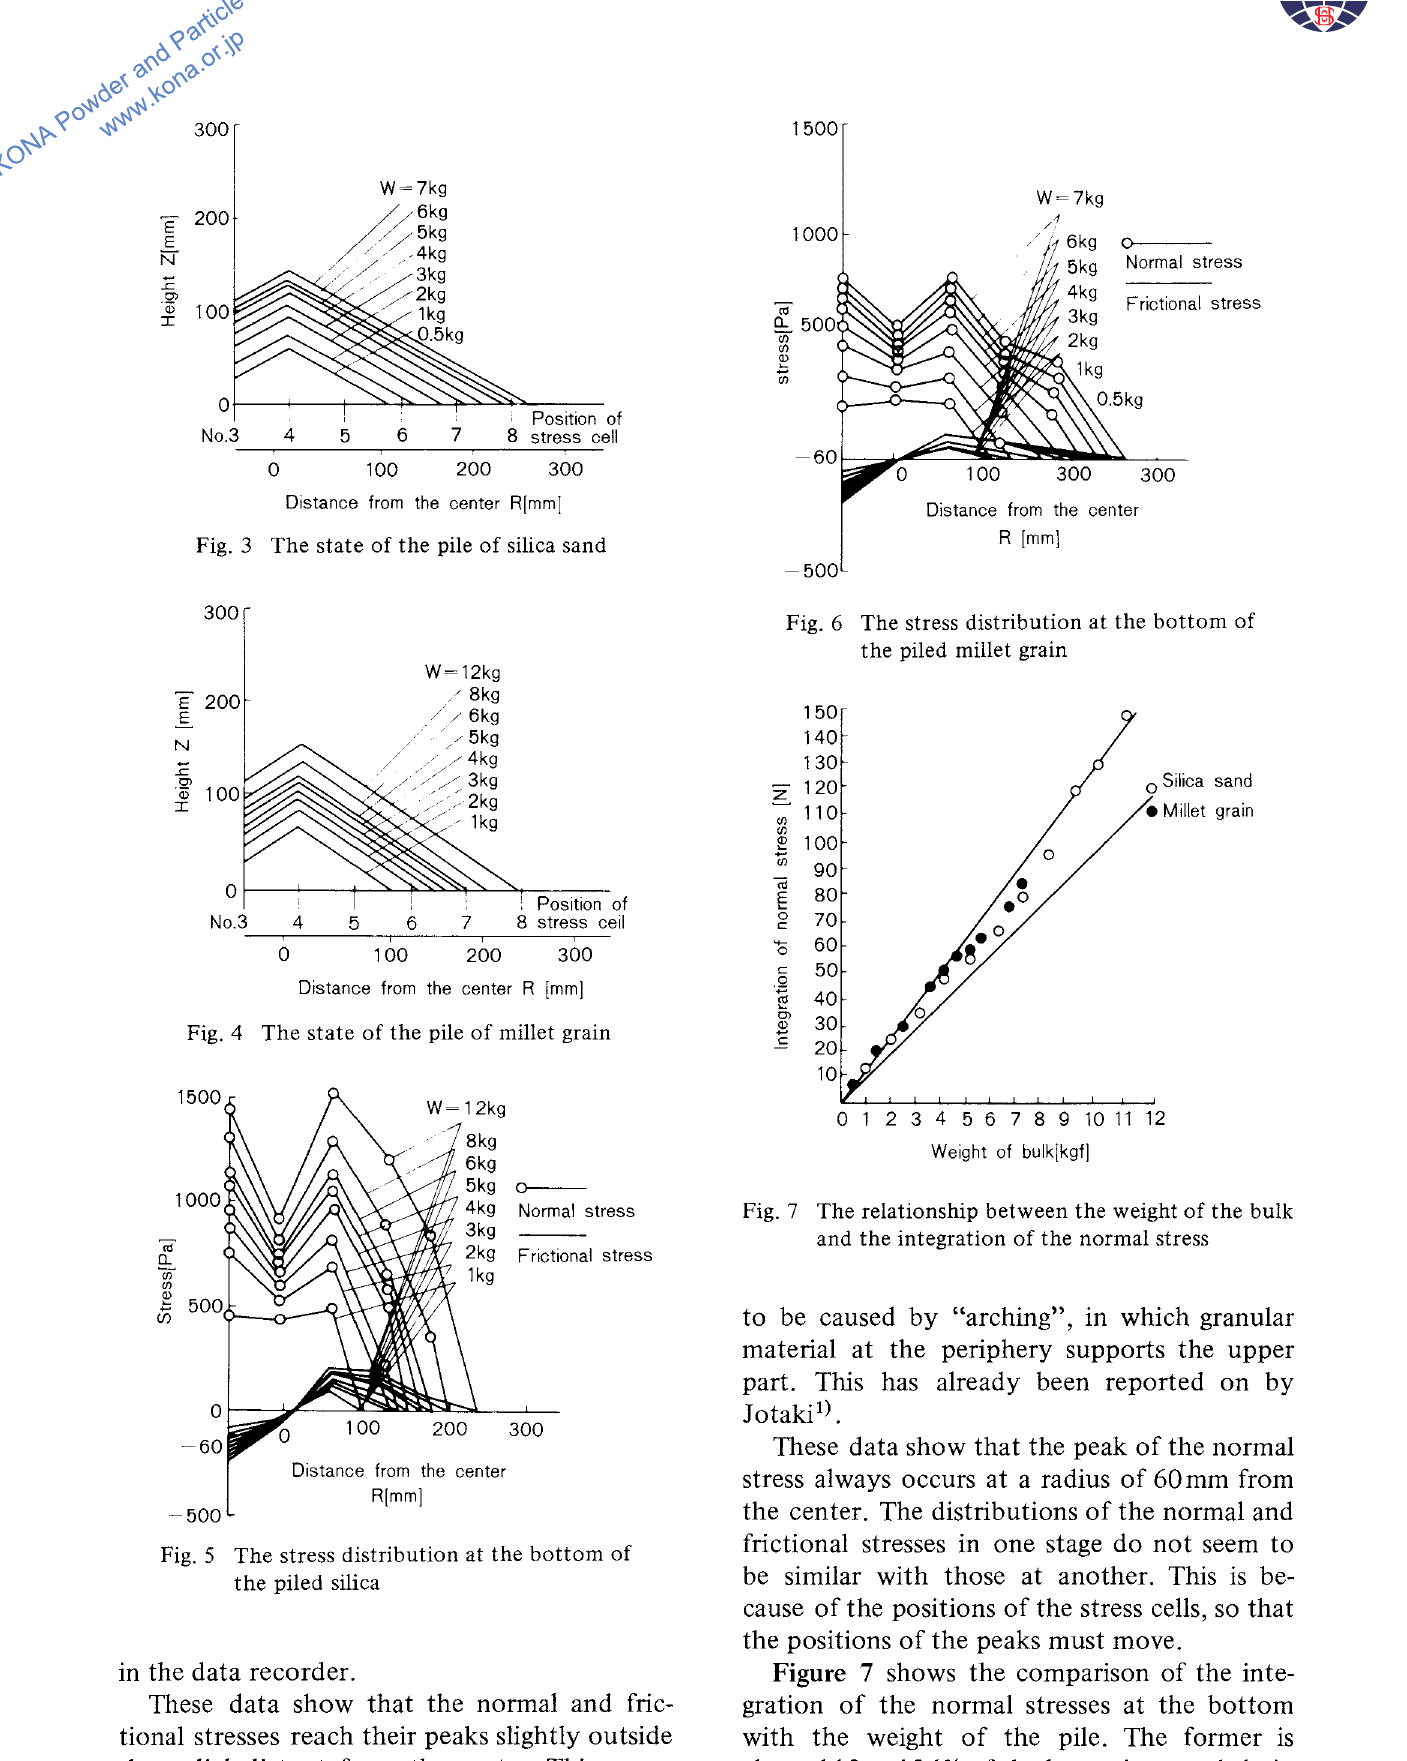
in the data recorder.